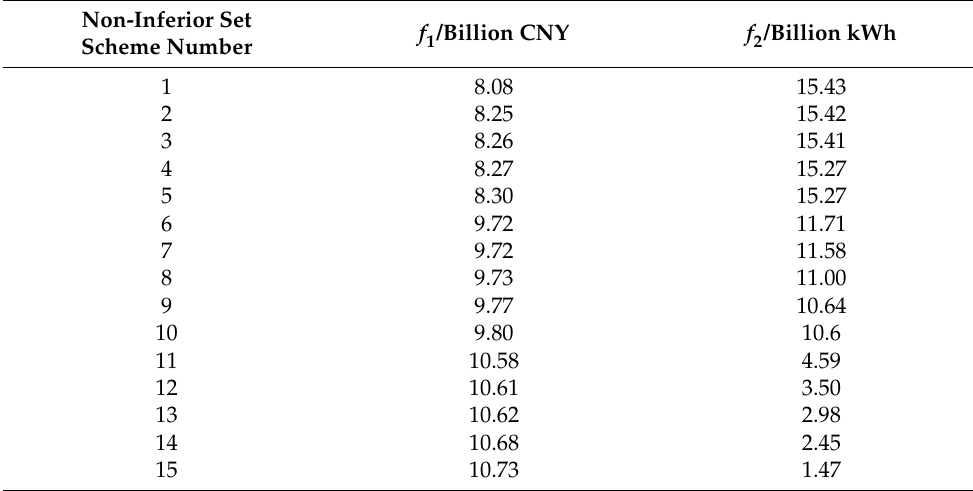
Table 3. Non-inferior set of two objective